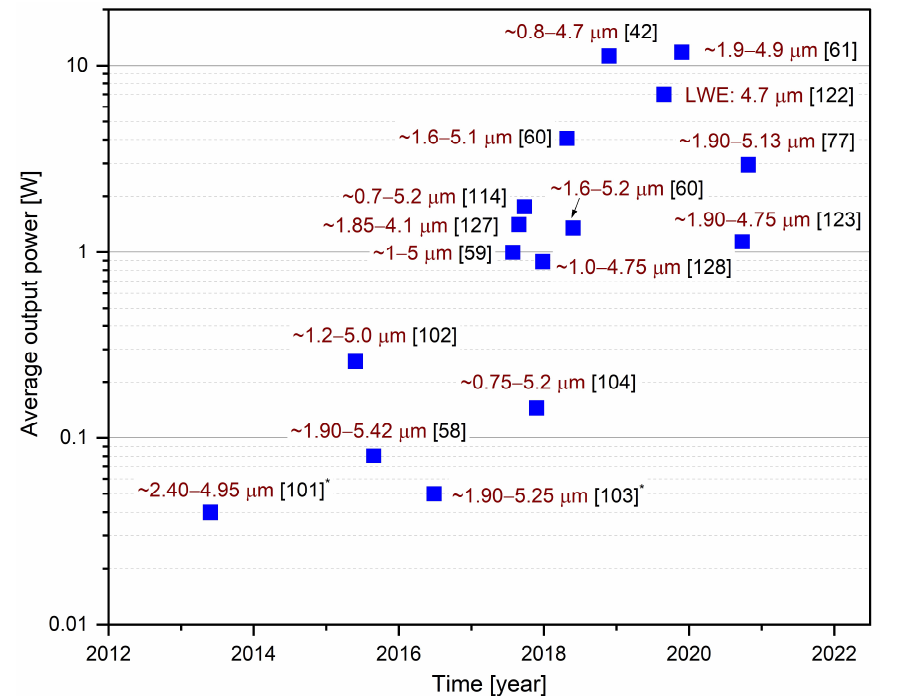
Figure 14. Summary of the most important reports on SC generation (with an LWE of output spectrum beyond 4 μm) in fluoroindate fibers published in the last decade. The bandwidth in the diagram represents the full spectral range (* average output power not revealed; it is supposed to be <100 mW).